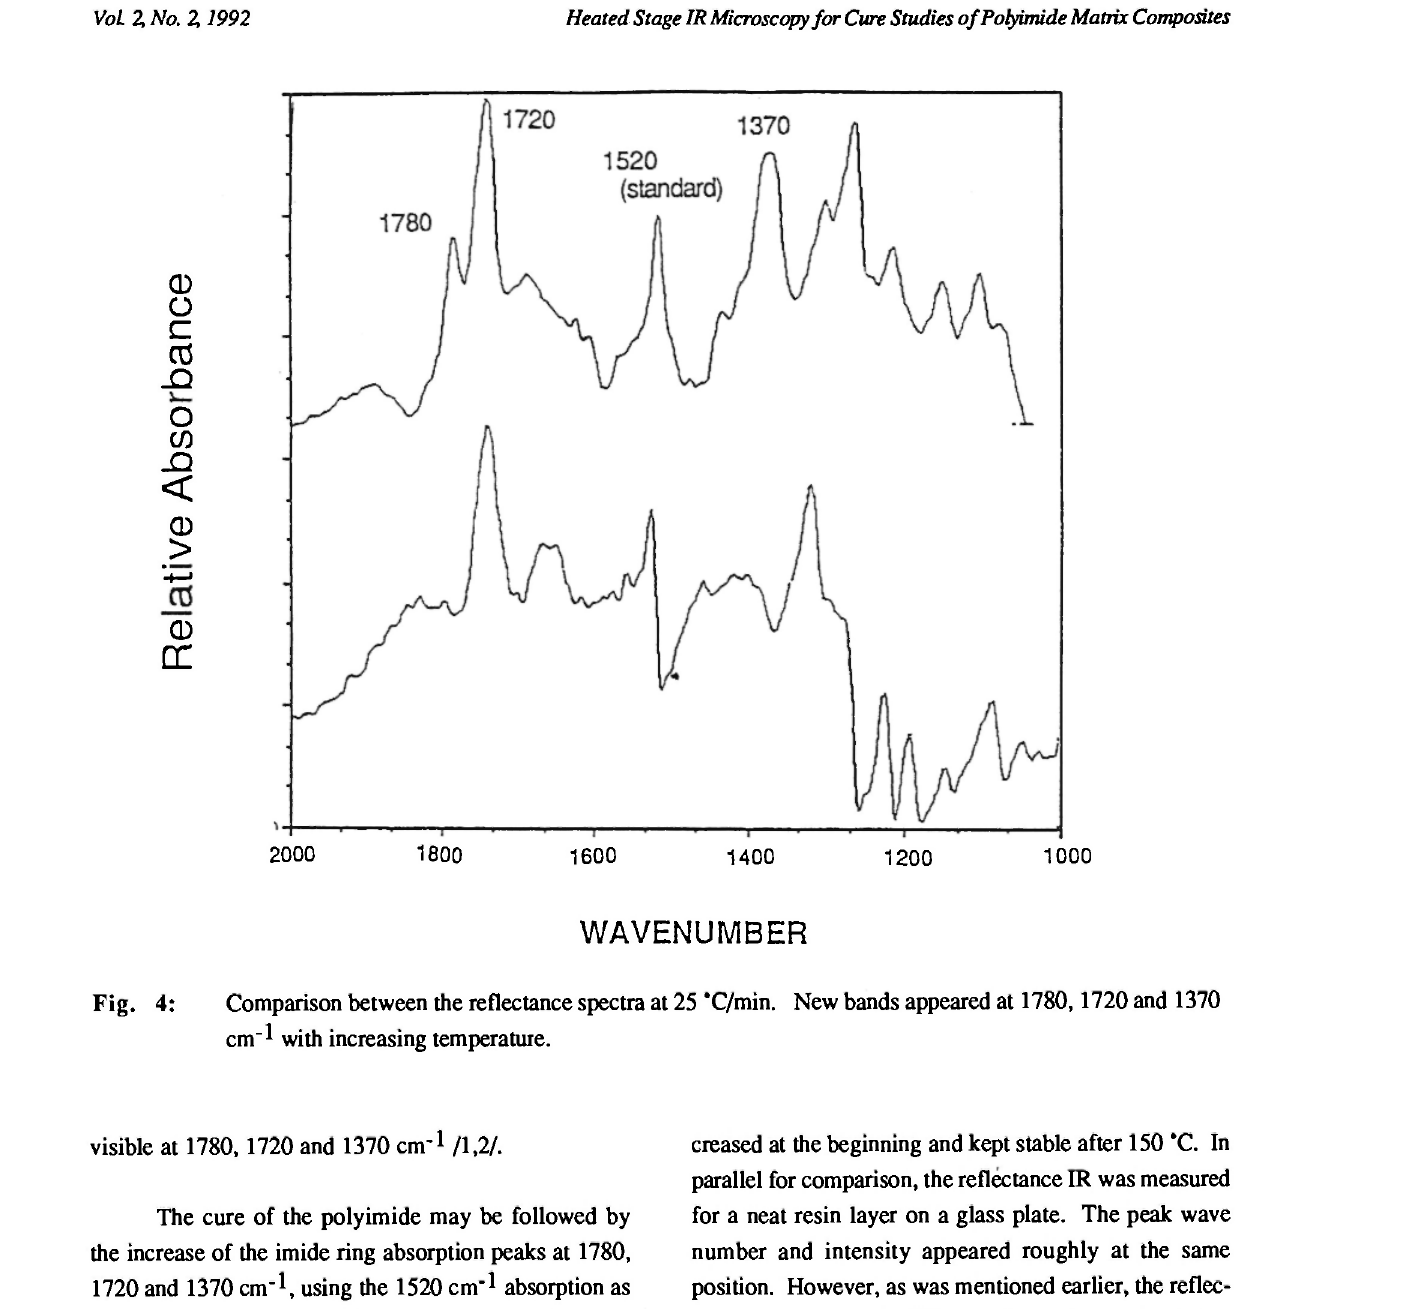
4: Comparison between the reflectance spectra at 25 'C/min. New bands appeared at 1780,1720 and 1370 cm -1 with increasing